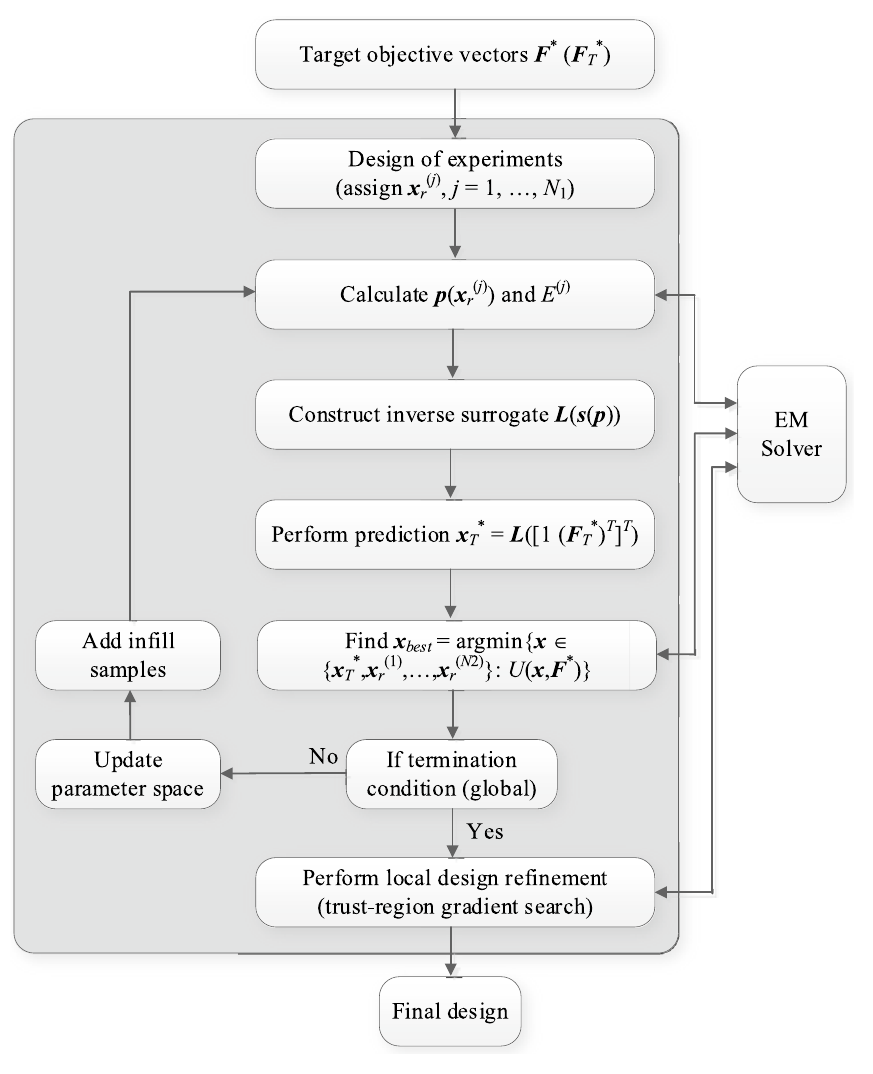
Figure 5. Flow diagram of the proposed globalized optimization framework involving response features and inverse